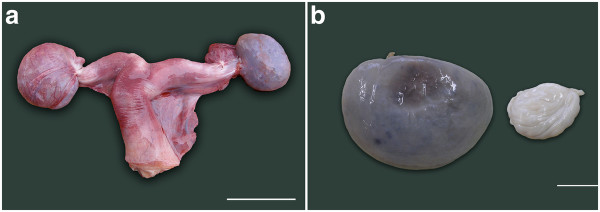
 a) The uterus and ovaries of an elephant fetus at 17.5 month of gestation. The ovary on the left is still enclosed within its ovarial sac (Scale bar = 50 mm). b) Ovary from a 20.2 month old elephant fetus on the left and a 6 month old calf on the right showing great shrinkage around the time of birth due to the reduction in both the size and number of interstitial cells (Scale bar = 20 mm).